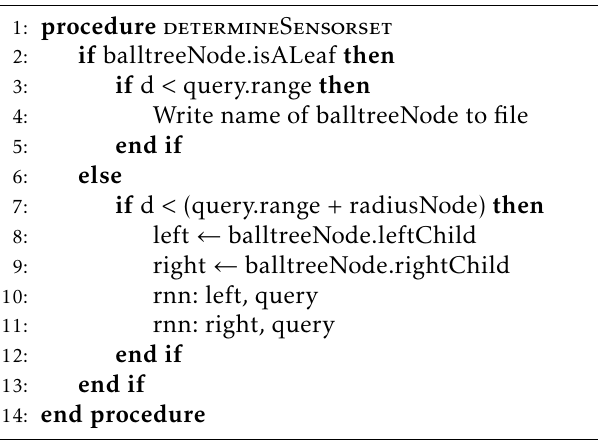
Algorithm 2 Determine a sensorset